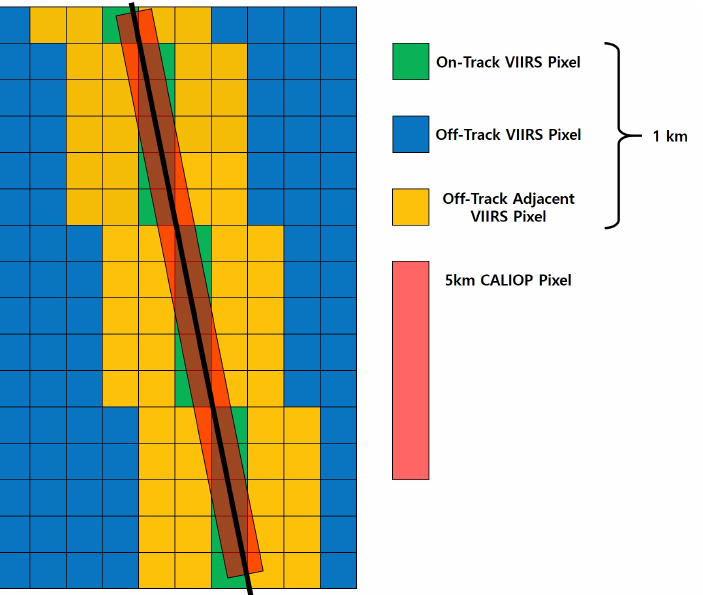
Figure 1. Illustration of on-track, off-track, and adjacent VIIRS pixels as well as CALIOP